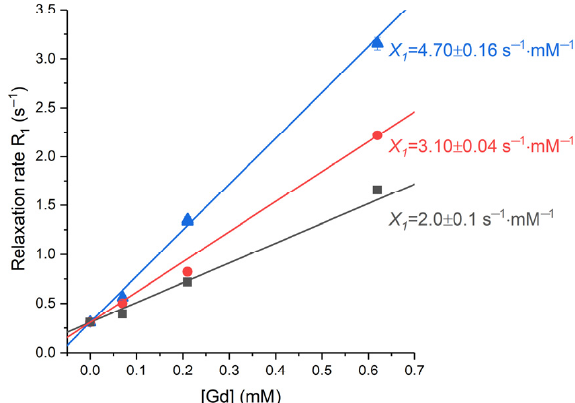
Figure 12. The dependencies of relaxation rate on the concentration of gadolinium for Samples 1–3 at 16.4 T, 27 ◦ C. Black squares—Sample 1, red circles—Sample 2, blue triangles—Sample 3. Lines show the best linear fit of the data; longitudinal-relaxivity values are provided near the corresponding lines.